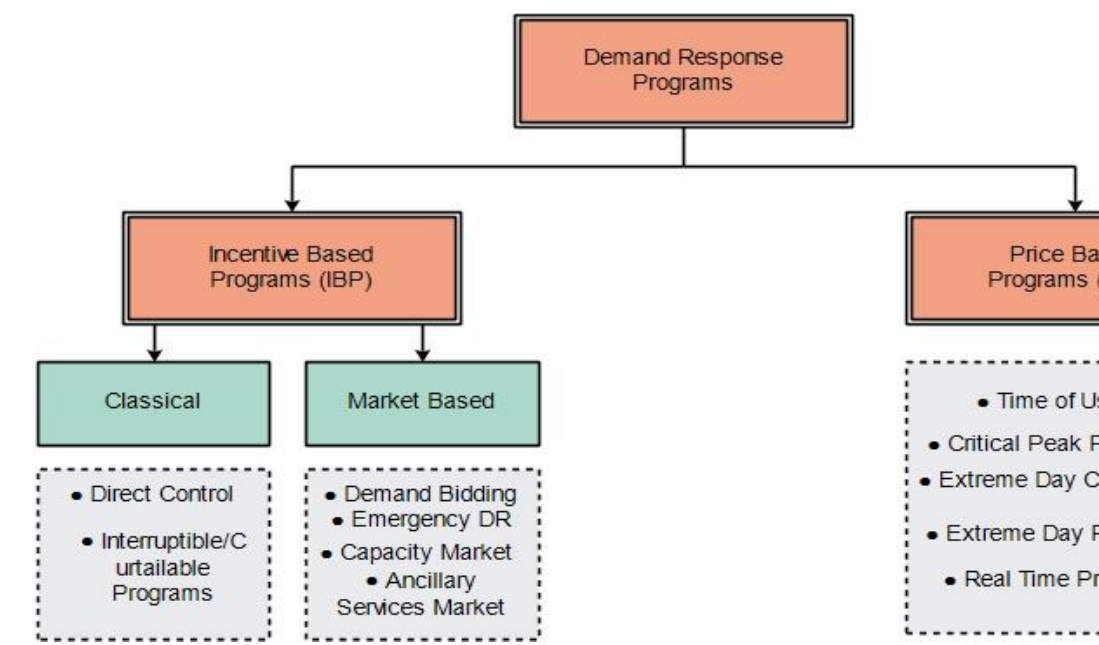
Figure 2. Classification of DR programmes.